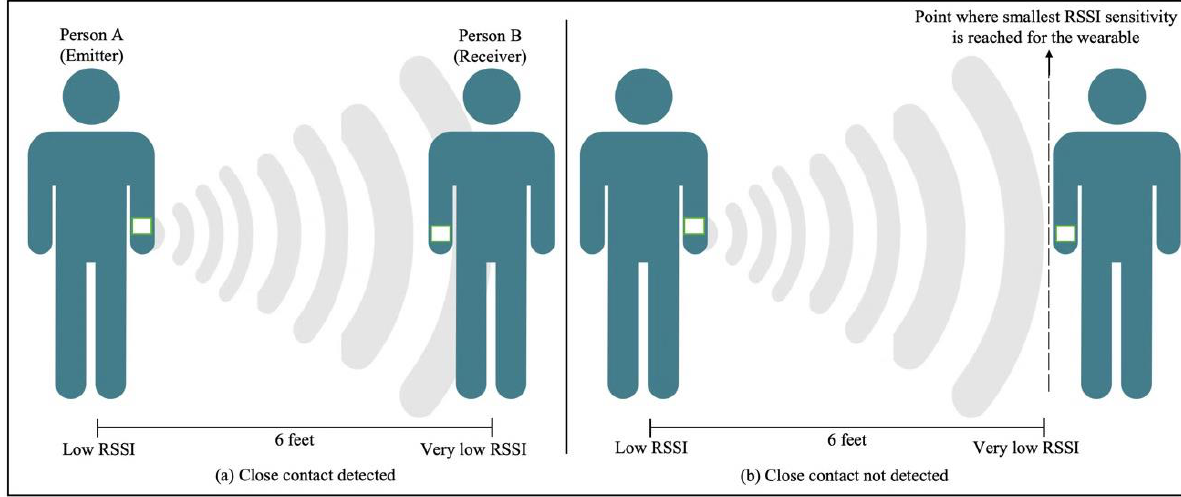
Figure 3. (a) Close contact detected; (b) Close contact not detected